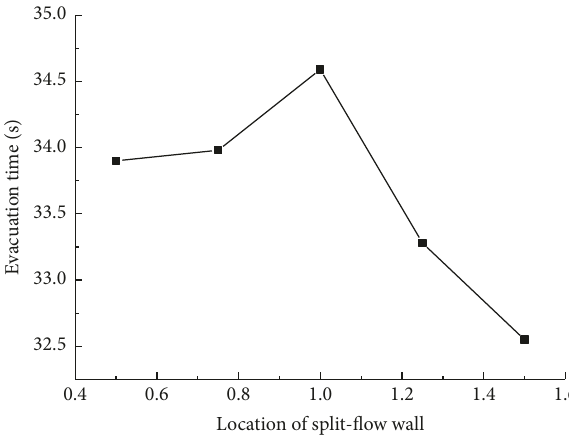
Figure 10: Evacuation time when 𝐿 = 1.5 , 𝜌 = 0.3 .